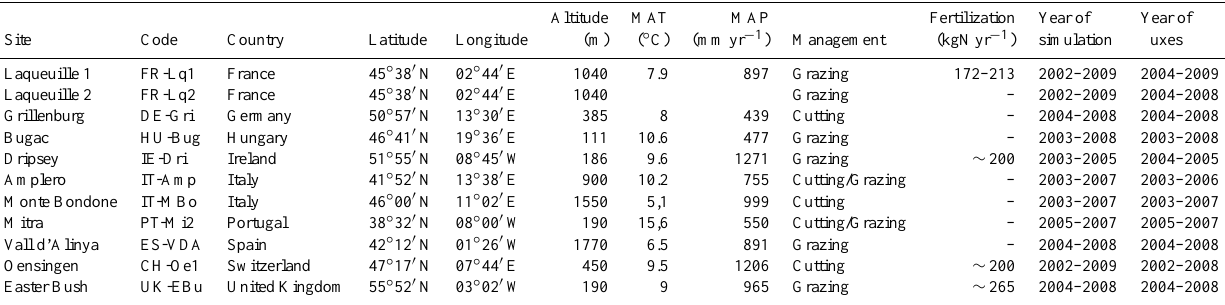
Table 1. Location, climate and management for the 11 managed grassland sites in Europe (from the FLUXNET program, http://www.fluxnet. ornl.gov; Baldocchi et al.,